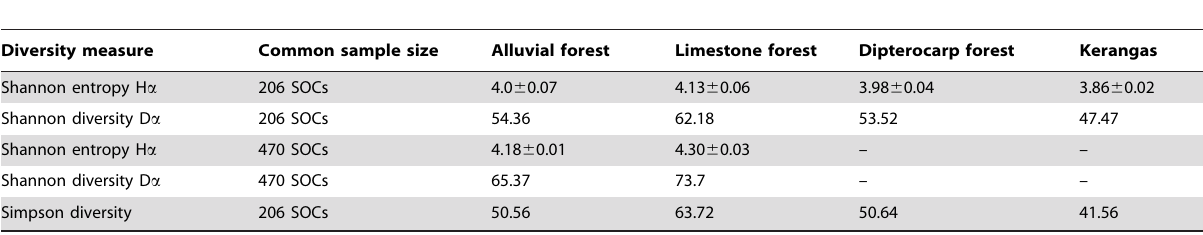
Table 2. Alpha diversity measures at different sample size for the four forest